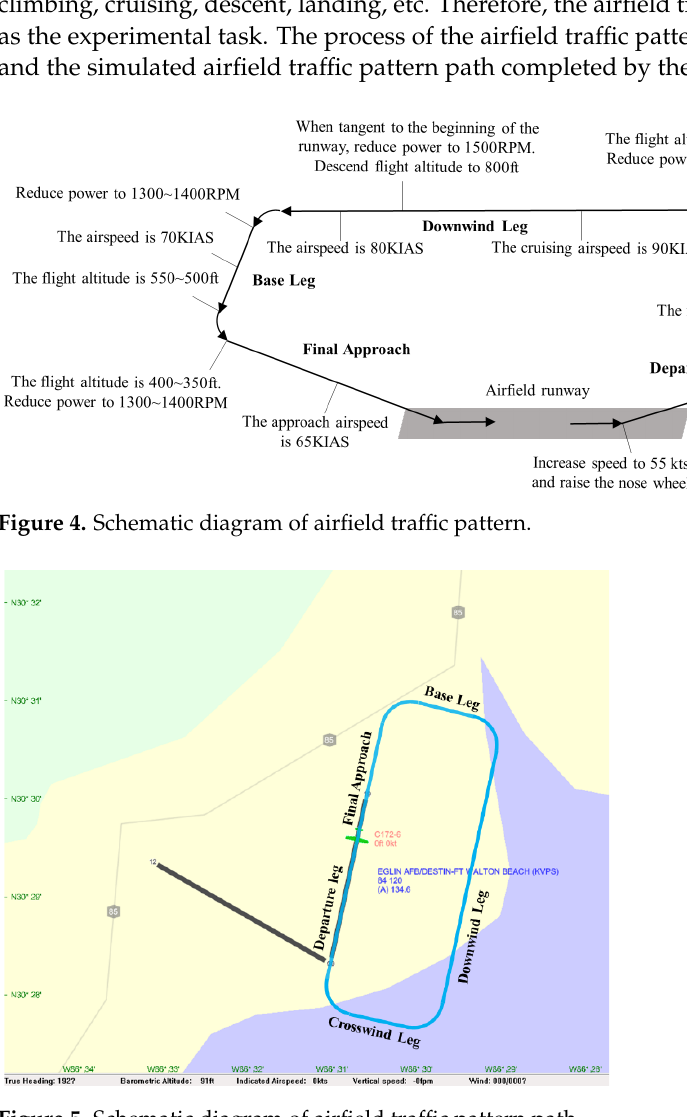
Figure 5. Schematic diagram of airfield traffic pattern path.